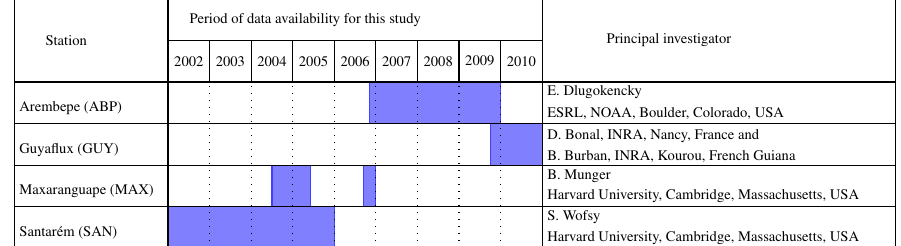
Figure 2. List of surface stations over South America added to the previous setup in MACCv10.1.